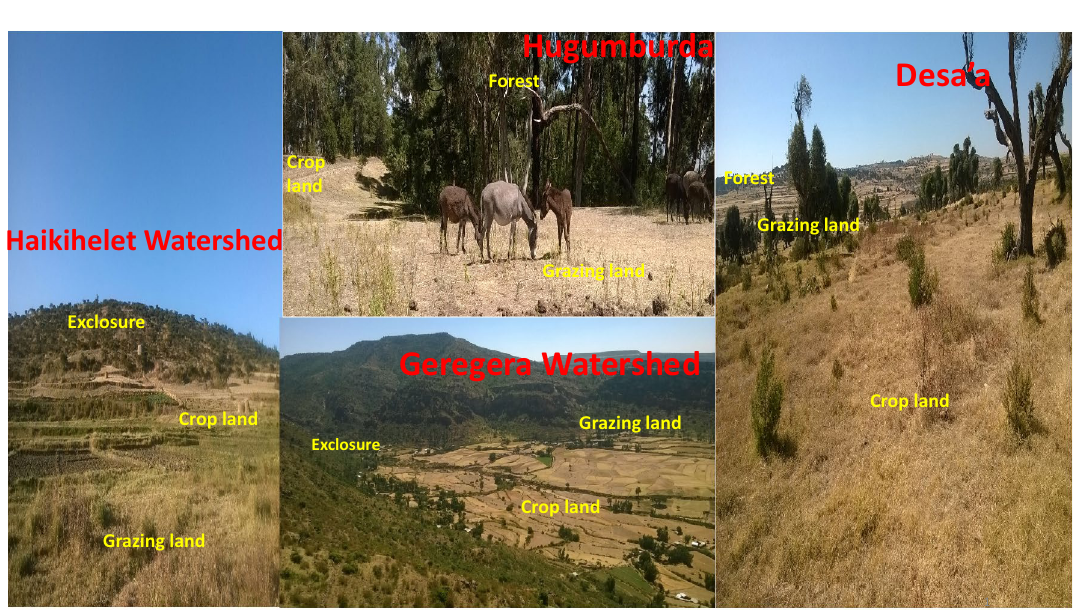
Figure 2. Pictorial view of all locations and their land use types (Courtesy of Okolo CC_December